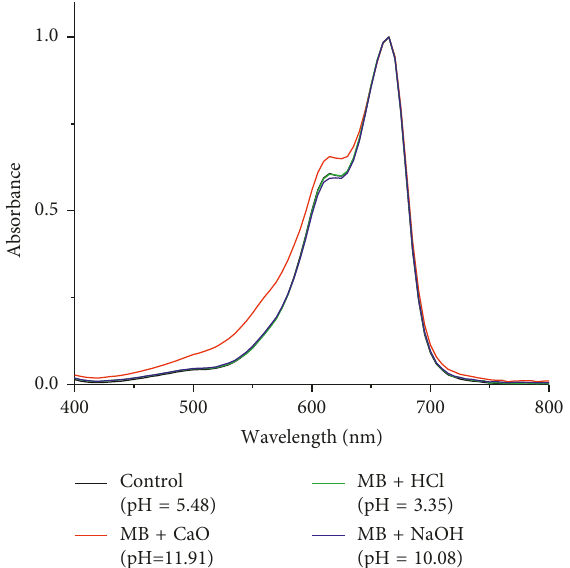
Figure 5: Absorbance curves of MB solution in different pH